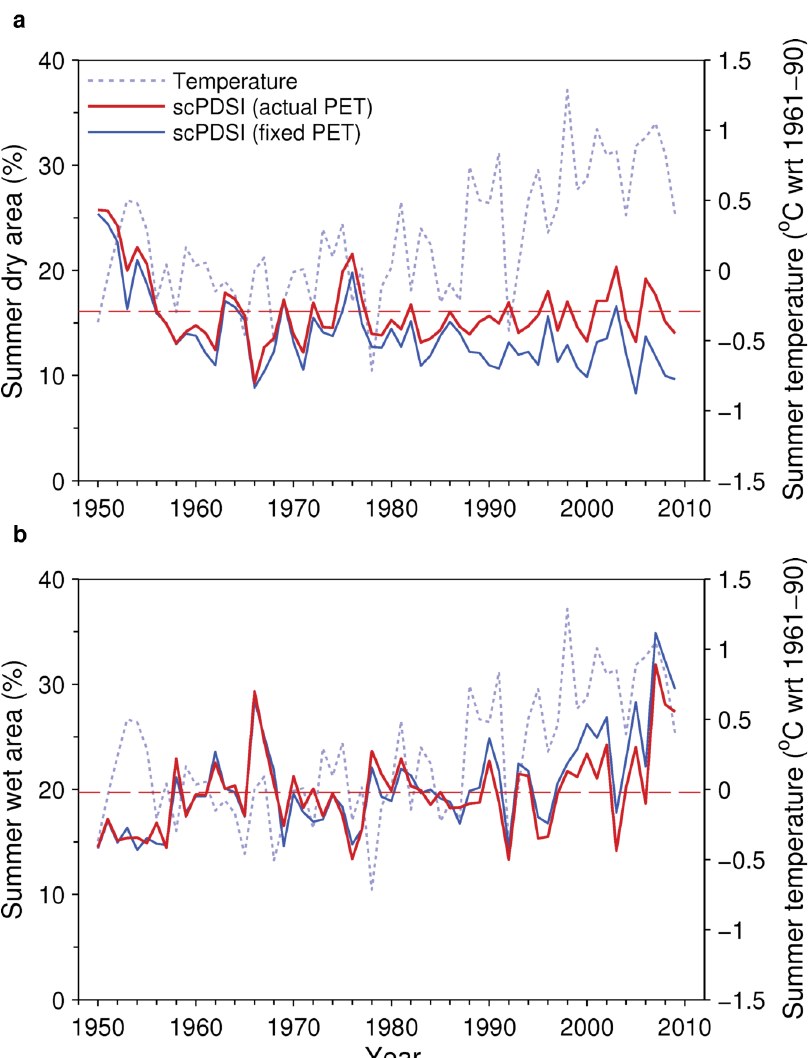
Figure 1. Temporal variability in percentages of summer dry and wet areas in the northern latitudes ( > 45 ◦ N) between 1950 and 2009 based on the scPDSI computed with (red) and without (blue) interannual changes in potential evapotranspiration (PET). ( a ) dry area (summer scPDSI ≤ − 2); ( b ) wet area (summer scPDSI ≥ 2). Also shown are the mean summer temperature anomalies for the region (gray dotted line) and the long-term mean of the percentage area series based on actual PET (red dashed